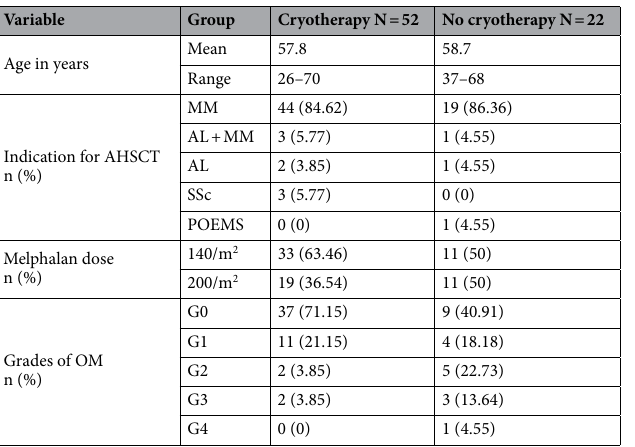
Table 1. Baseline characteristics of analysed patients with or without cryotherapy. OM oral mucositis, AHSCT autologous hematopoietic stem cell transplantation, MM multiple myeloma, AL light chain amyloidosis, SSc systemic sclerosis, POEMS polyneuropathy, organomegaly, endocrinopathy, monoclonal gammopathy, skin abnormalities.